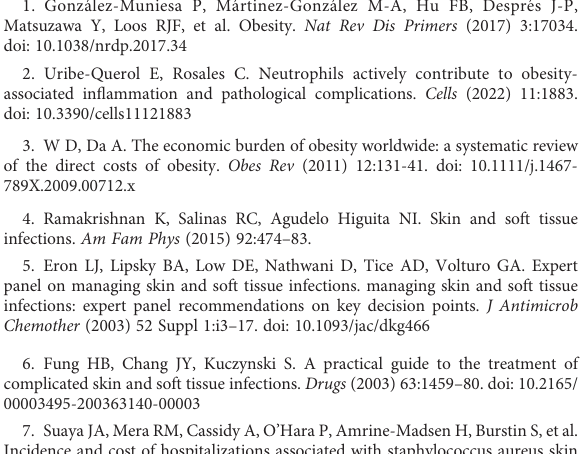
SUPPLEMENTARY FIGURE 3 Leave-one-out analysis plots for BMI on SSTIs. MR, Mendelian randomization; SSTI, skin and soft tissue infection; BMI, body mass index. SUPPLEMENTARY TABLE 1 Data source information. BMI, body mass index; T2D, type 2 diabetes; SSTI, skin and soft tissue